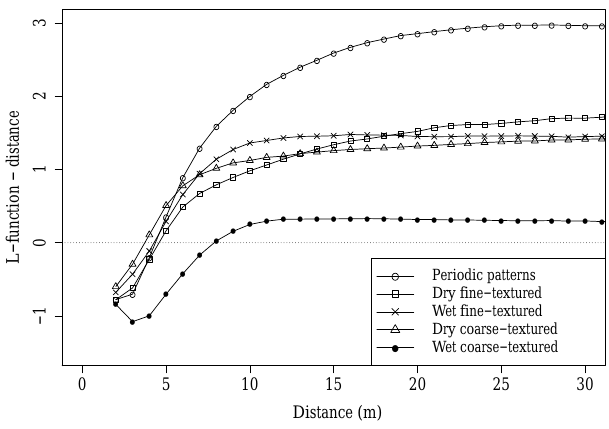
Figure 9. Level of aggregation among tree crowns calculated using Ripley’s K transformed to Besag’s L function. The figure shows the mean values of five categories: sites with periodic vegetation patterns, and four subdivisions based on mean annual precipitation and soil texture. Sites classified as having periodic patterns were not included in the latter subdivisions. Sites with MAP below 600mm were categorized as dry, whereas sites with a sand content below 60% were categorized as